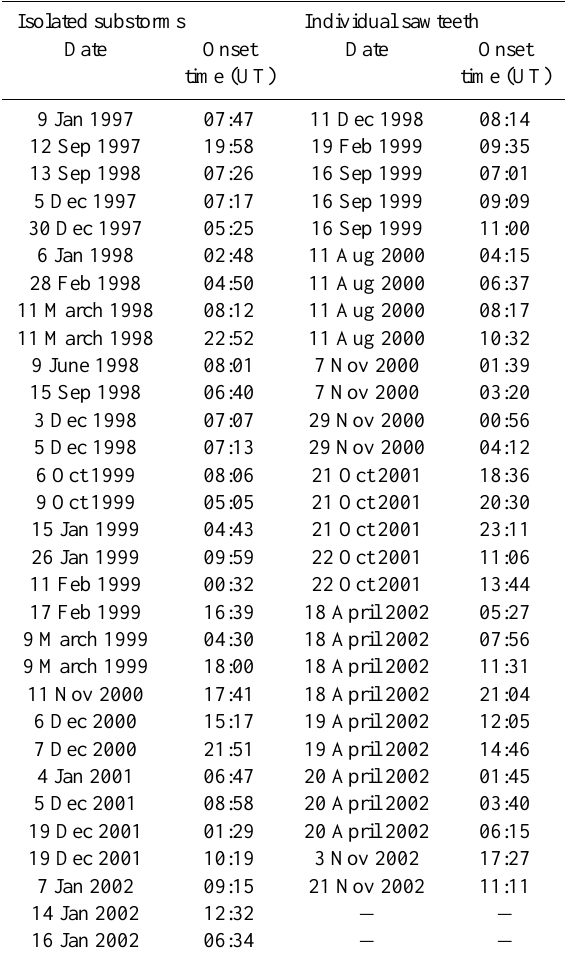
Table A2. A List of isolated substorms and individual sawteeth used in the statistical study. Only events with good auroral imag- ing were chosen. Onset times for the isolated substorms are deter- mined by mid-latitude magnetometer data and onsets for the indi- vidual sawteeth are determined using LANL SOPA data (Cai et al.,